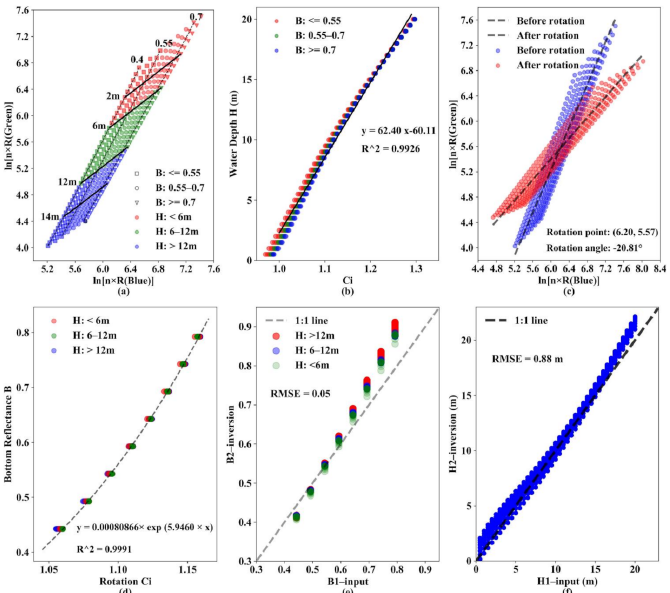
Figure A3. The Hydrolight simulation result at 0.15 mg/m 3 of Chl-a. ( a ) Hydrolight simulation reflectance of blue–green bands. Different colors represent different water depths, and different